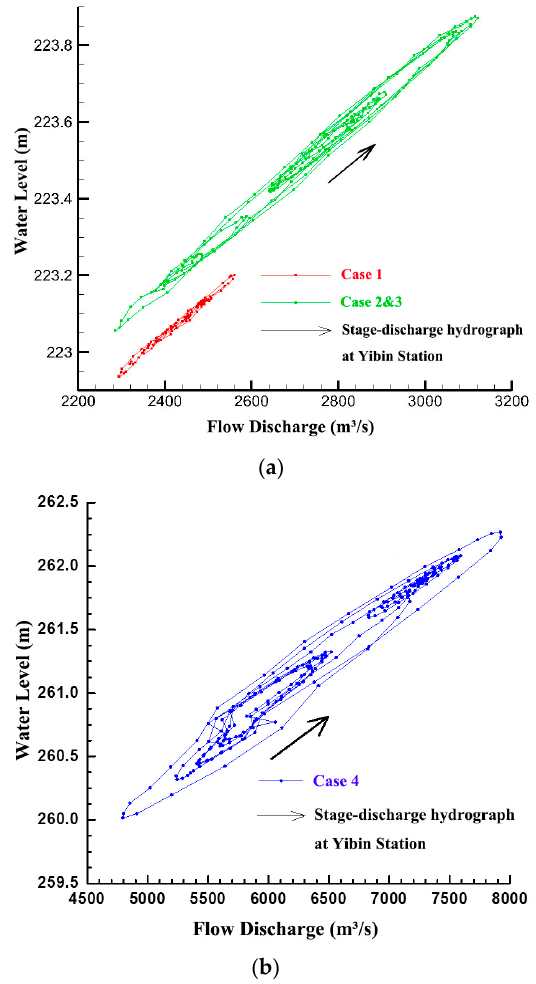
Figure 8. Stage–discharge hydrograph at Yibin Station: ( a ) Case 1–3; and ( b ) Case 4.